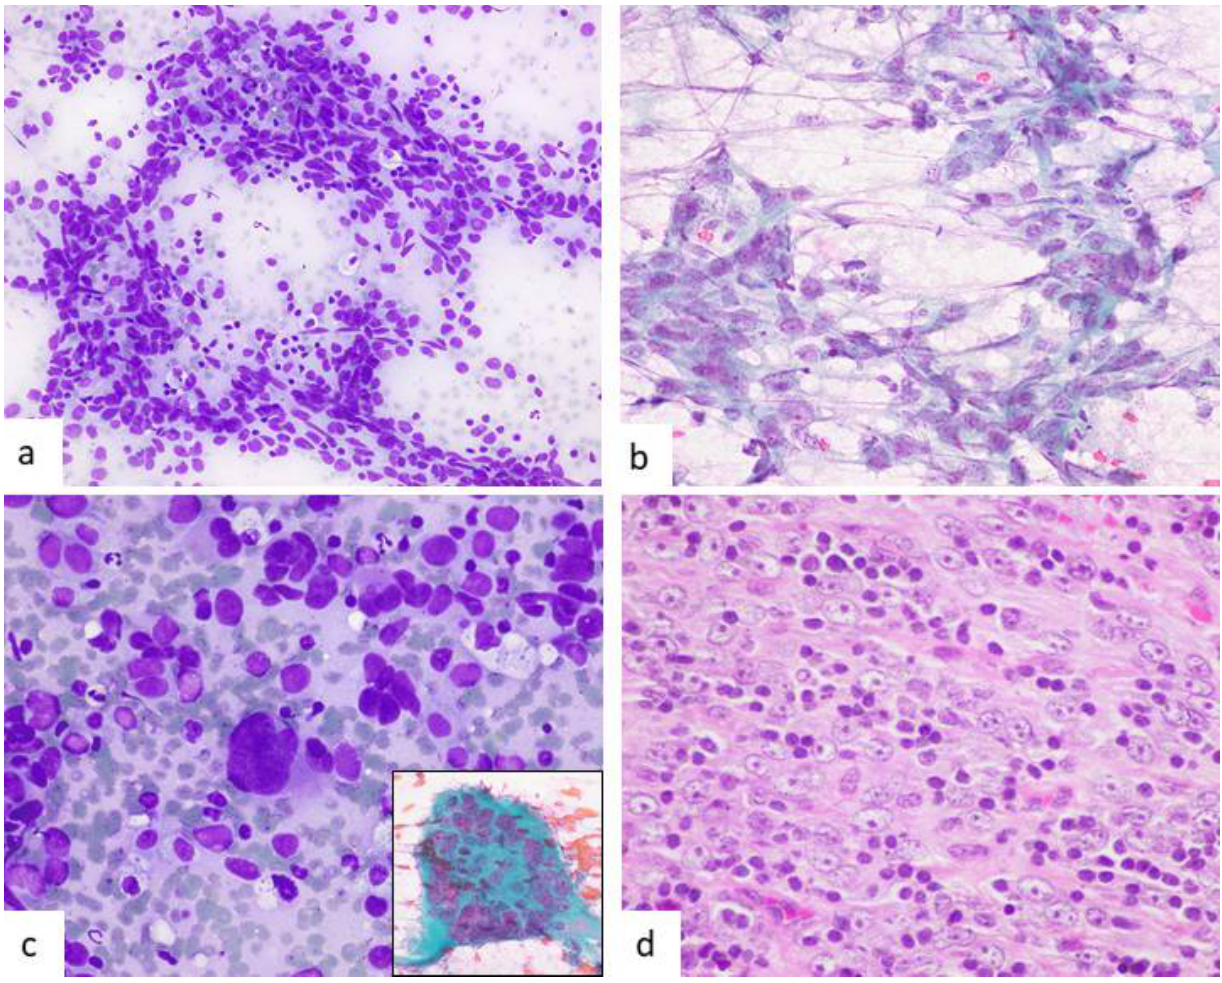
Figure 2. A case of recurrent FDCS. ( a ) Ill-defined aggregates of oval to spindle cells and lymphocytes (Diff-Quik, ×200). ( b ) Long cytoplasmic interconnecting processes create a fibrillary appearance (Papanicolaou, ×400). ( c ) Occasional cells showed nuclear atypia (Diff-Quik, ×400). The inset shows a large multinucleated cell (Papanicolaou, ×600). ( d ) Histological image with large tumoral cells with vesicular nuclei, prominent nucleoli, and numerous lymphocytes (HE, ×400).